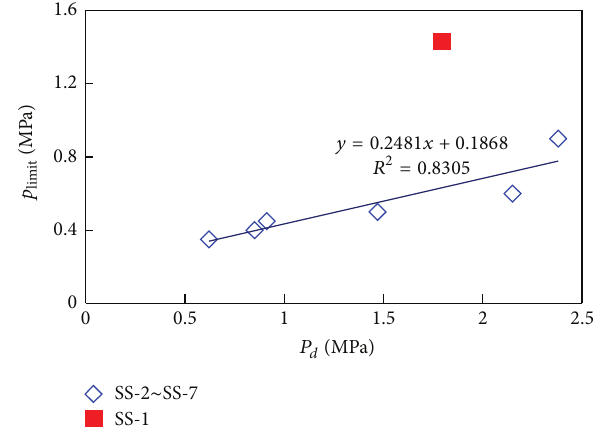
Figure 8: Relationships between integrated logistics index and 𝑝 for tight core samples.